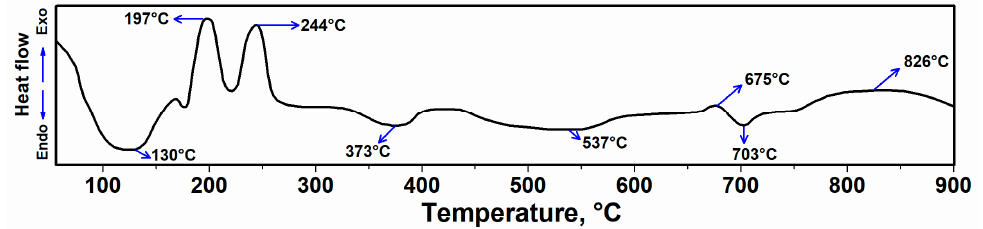
Figure 5. DSC of rolled hair band consisted of Ag-doped HA+PVTMS+CH 3 COOH+H 2 O.